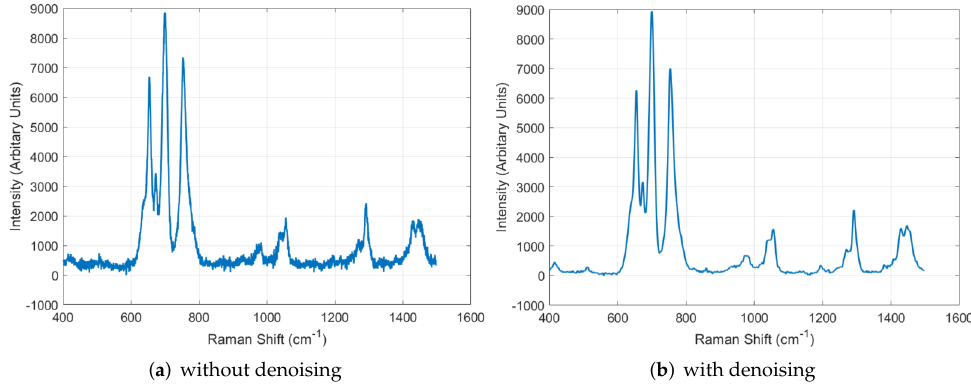
Figure 10. Performance comparison between the results with and without denoising.